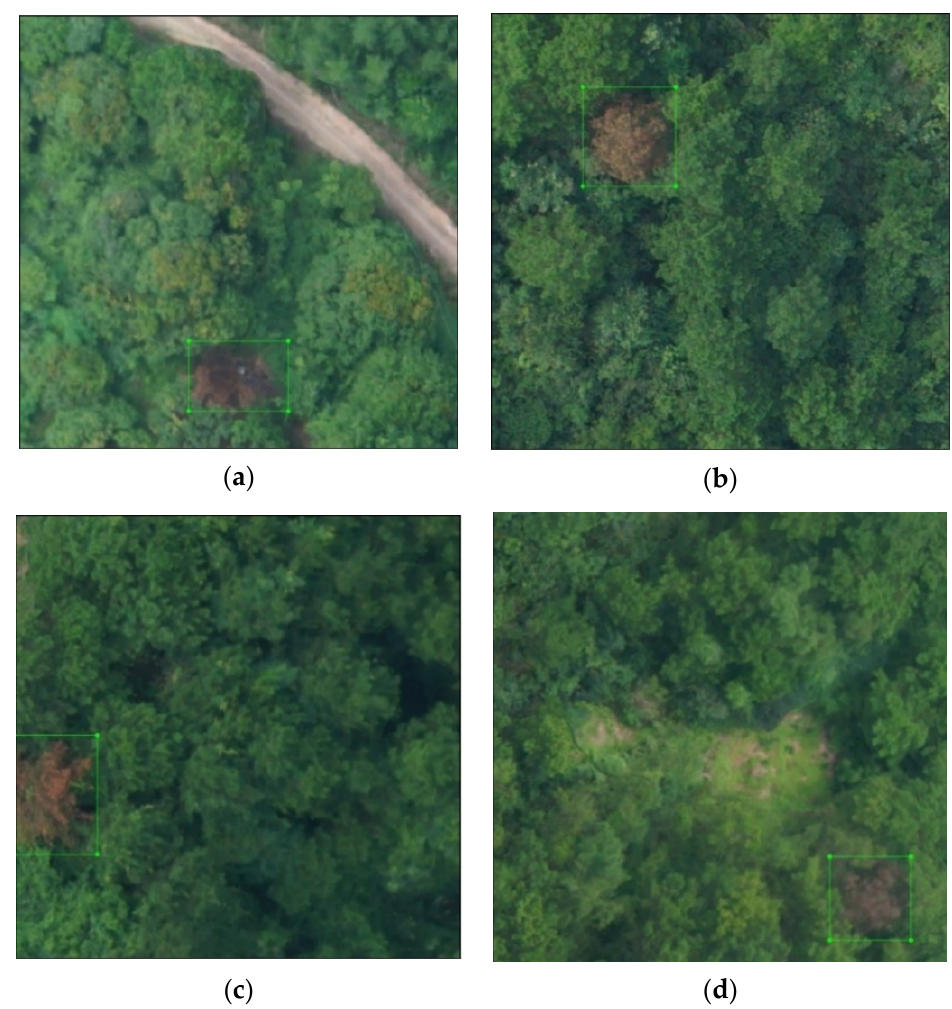
Figure 5. Annotated dataset example. ( a ) Annotation example 1; ( b ) Annotation example 2; ( c ) Annotation example 3; ( d ) Annotation example 4.